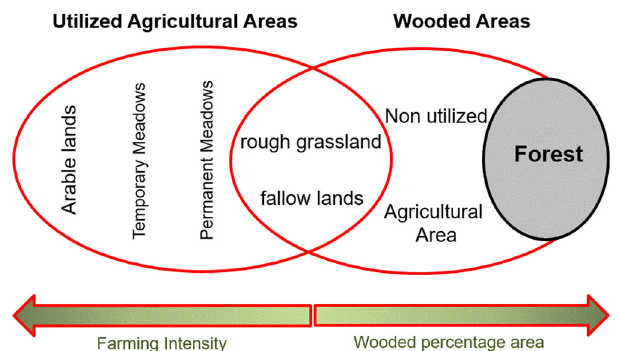
Figure 1. The frontier between utilized agricultural land, non-utilized agricultural land, and forest.